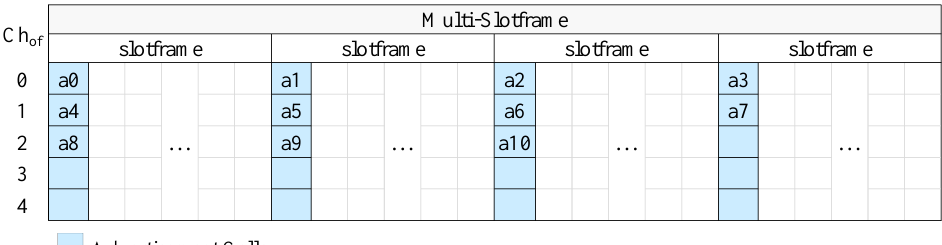
Figure 4. CFAS using vertical indexing in the case where there are 5 available channels, 11 advertisers (including the PAN coordinator), S = 4 and A s = 1, while the identifiers of the advertisers are consecutive and start from 0.